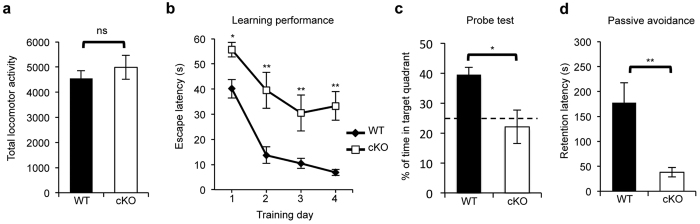
BCAS2 cKO mice show impaired cognitive behavior.(a) Locomotor activity in the open field test. cKO mice (n = 14) showed no difference compared to WT mice (n = 10) in the open field test analyzed by Student’s t-test. (b) Morris water maze. The latency of BCAS2 cKO mice to find the hidden platform was longer than that of WT for 4 constitutive training days. Two-way ANOVA (genotype versus day) revealed a major genotype effect and day effect for both groups. (c) Probe test after the Morris water maze, 24 hours after the last training day. The hidden platform was removed, and the percentage of time spent in the target quadrant was analyzed by Student’s t-test (WT, n = 5; cKO, n = 6). (d) Fear memory analysis. The passive avoidance test was performed using the Gemini avoidance system with a foot shock of 0.1 mA for 3 s. On the test day, the retention latency of the mouse in the light chamber was recorded, and the maximum time was set to 300 s. The data are shown as the mean ± S.E.M., and the P value was analyzed by a two-tailed Student’s t-test (WT: n = 5; cKO: n = 7). All tested mice of each genotype were at 12 weeks old.